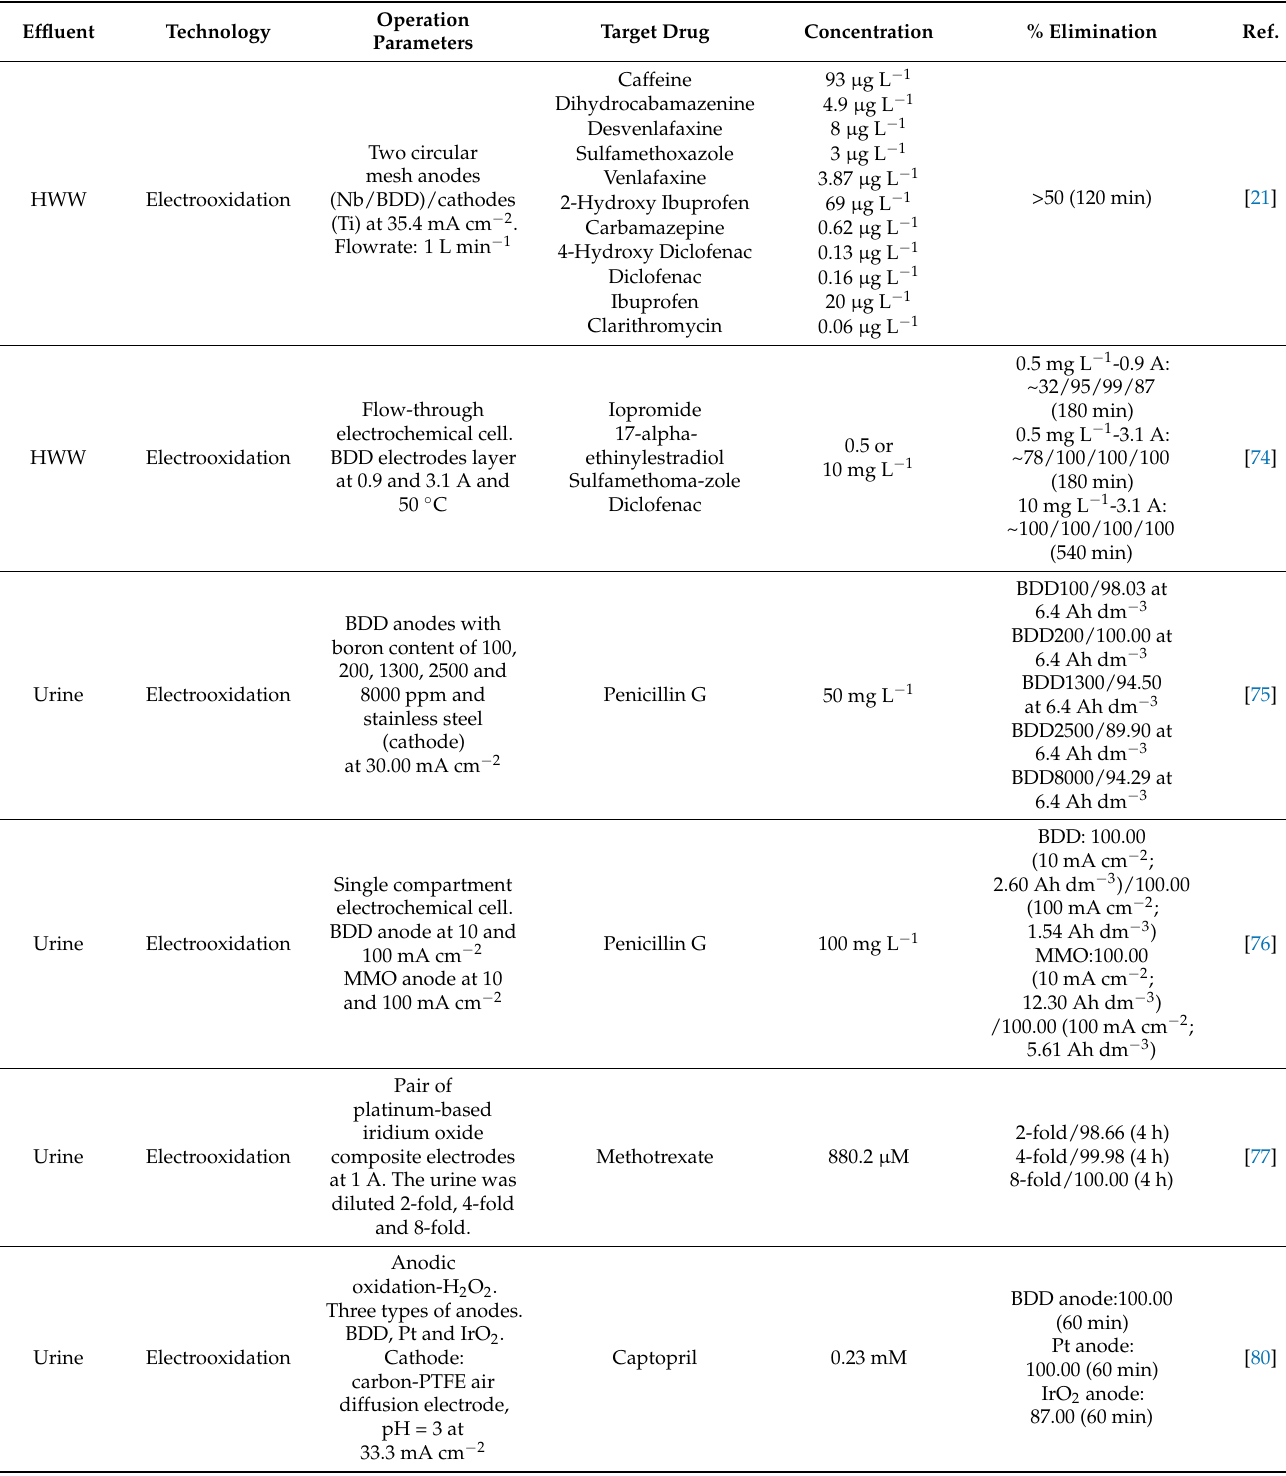
Table 4. EAOPS for the removal of PhCs in